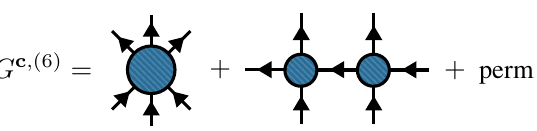
Figure 1: Connected correlation functions from irreducible building blocks. We show the diagrammatic contributions to the 1PI connected six-point function ( G c , ( 6 ) ). The first term involves a 1PI six-vertex, the second is assembled from two four-vertices. Field indices and permutations of external legs are implied and the number of in- and outgoing arrows is conserved due to U ( N ) invariance. For details, see also ap- pendix